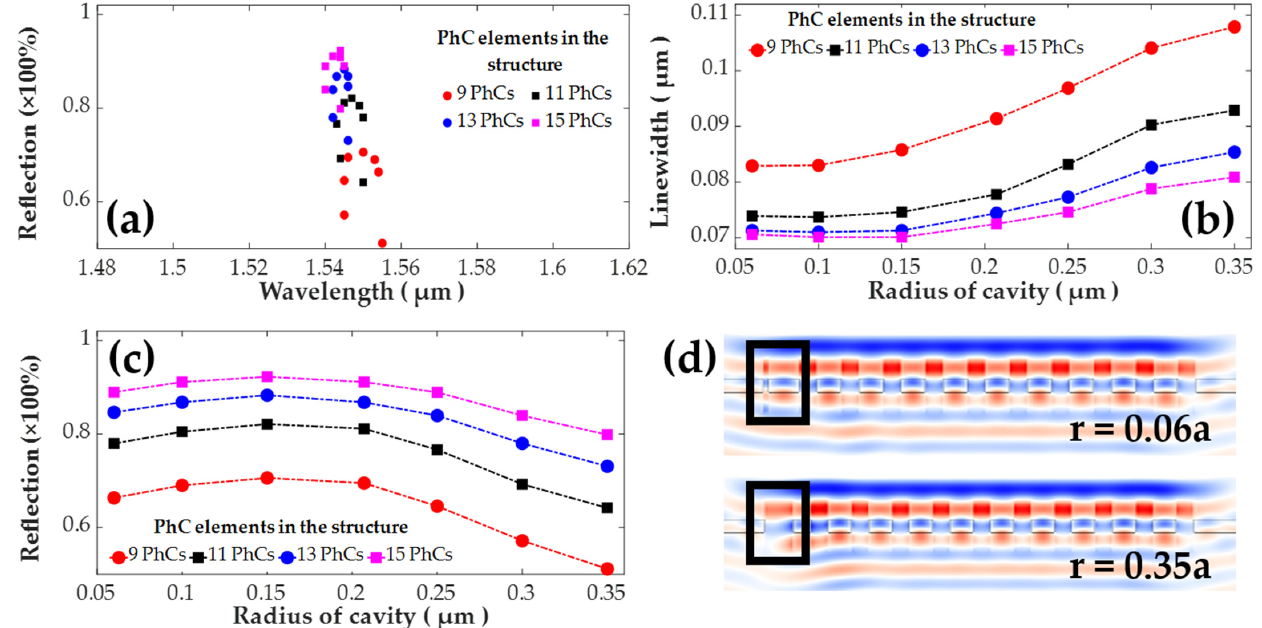
Figure 7. Analysis of spectral properties of PhC structures for variation in number of PhCs and cavity-radius. ( a ) Reflection vs wavelength. ( b ) Linewidth vs cavity-radius. ( c ) Reflection vs. cavity-radius. ( d ) EM field distribution for cavity-radii as r = 0.06a and 0.35a.